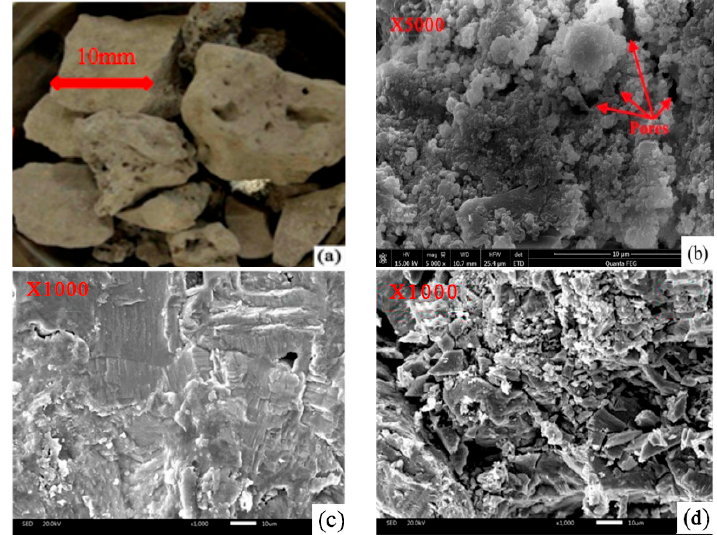
Figure 1. Macro and micro morphology of BOF slag. ( a ) is macro morphology; ( b – d ) are micro morphology.